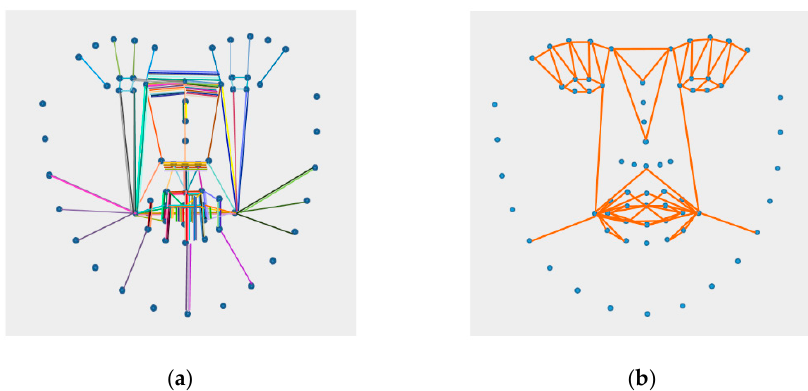
Figure 3 . Landmark sets for defining the geometric feature descriptor. ( a ) Landmark set for the distance ratio and ( b ) landmark set for the angle relations.